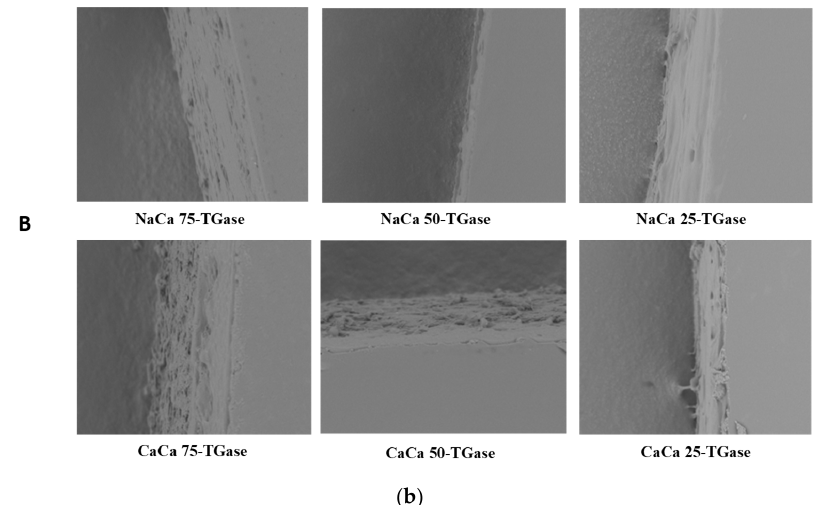
Figure 3. ( a ) Scanning electron micrographs of ( A ) surfaces (magnification × 600) and ( B ) cross-sections (magnification × 1200) of caseinates-carboxymethyl chitosan without transglutaminase [ CHCH = carboxymethyl chitosan; NaCA = sodium caseinate, CaCA = calcium caseinate, 100, 75, 50, and 25 represent the proportion of the individual component, the balance out of 100 being CMCH]. ( b ) Scanning electron micrographs of ( A ) surfaces (magnification × 600) and ( B ) cross-sections (magnification × 1200) of caseinates-carboxymethyl chitosan with transglutaminase [ CHCH = carboxymethyl chitosan; NaCA = sodium caseinate, CaCA = calcium caseinate, 100, 75, 50, and 25 represent the proportion of the individual component, the balance out of 100 being CMCH].